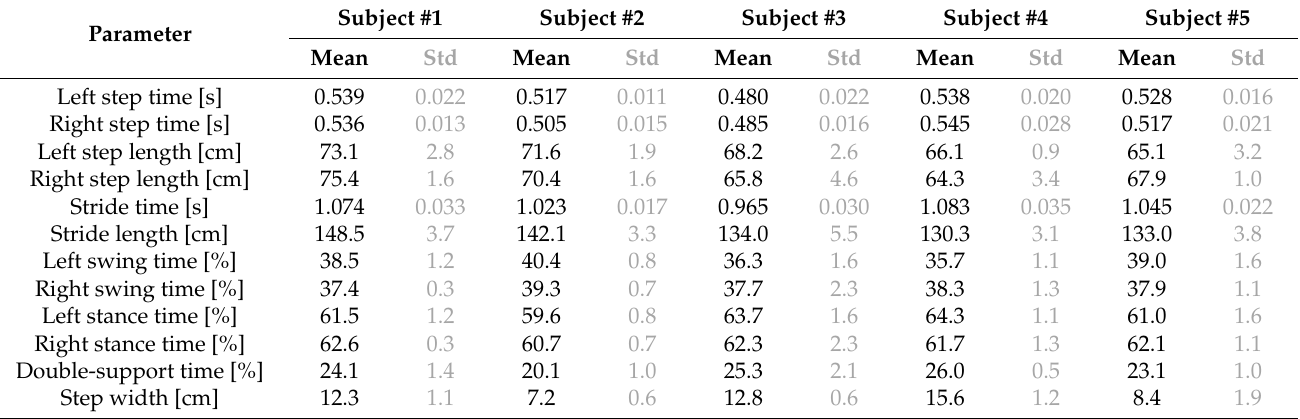
Table A1. Means and standard deviations (std) of the reference values of selected spatiotemporal gait parameters, obtained using the Zebris FDM